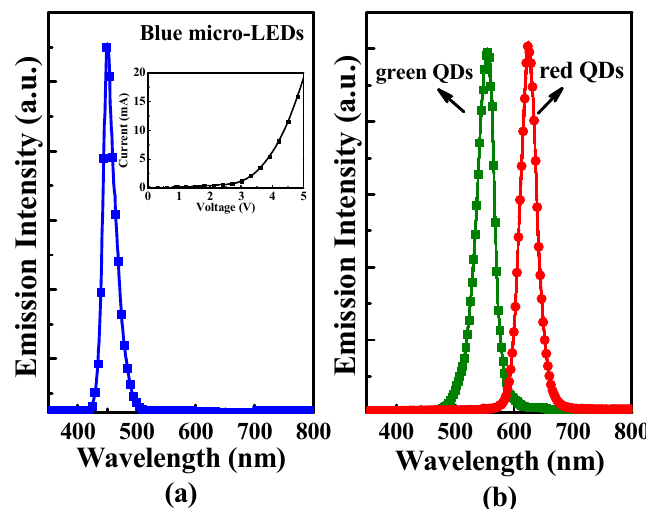
Figure 2. ( a ) The electroluminescence (EL) spectra of the GaN-based blue micro-LEDs operated at a bias of 3 V. The inset figure shows the current–voltage characteristics. ( b ) The emission spectrum of the green and red QDs.